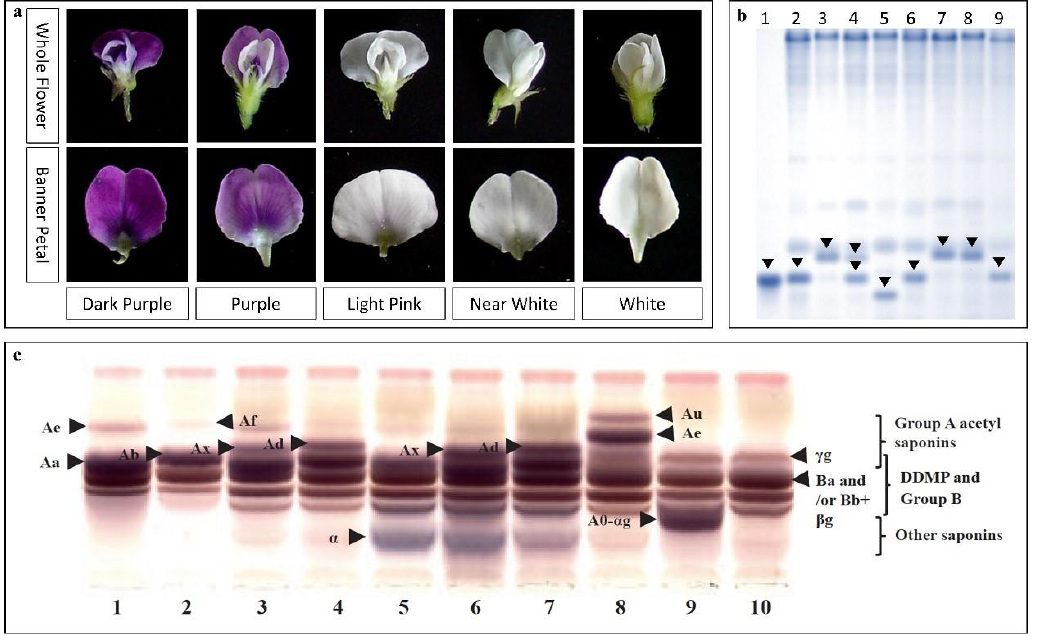
Figure 4. Demonstrations of the diversity in the CWLGC. ( a ) Flower color variations [40]. ( b ) Using Kunitz trypsin inhibitor, different KTi forms were detected in Korean G. soja accessions by non-denaturing PAGE. Lanes 1–9 are: Tia protein standard (Sigma), Tia, Tib, Tia/Tib, Tibi7-1, Tia, Tibi5, Tib, and Tia, respectively [111] . ( c ) Comparison of saponin composition phenotypes in seed hypocotyls in the Korean G. soja collection by thin-layer chromatography (TLC). Lanes 1–7 are the common phenotypes: Aa, Ab, AaBc, AbBc, Aa+a, AaBc+a, and AbBc+a types, respectively. Lanes 8, 9, and 10 are mutant phenotypes: AuAeBc (CWS0115), A0Bc+ag (CWS2133), and A0Bc-S (CWS5095) types, respectively [32] .